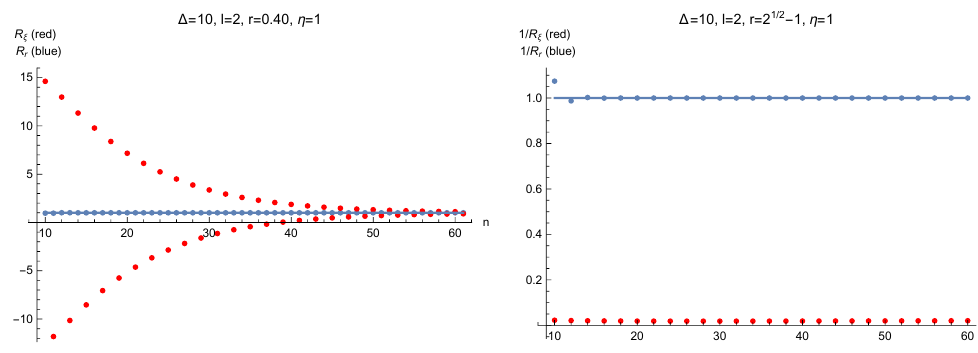
Figure 9 . Comparison of the expansion of the block g (cid:1) l of dimension (cid:1) = 10 and spin l = 2 in powers of (cid:24) (in red) and r (in blue). The meaning of the labels is as in eq. (4.20). The blue solid line is constant and equal to 1. The oscillation of R r and R (cid:24) , especially visible in the latter, follows from the fact that the two series expansions of the block are alternating. On the right, r is at the self-dual point, eq. (4.19). We plot R (cid:0) 1 because diverges at large n for (cid:24) R (cid:24) r;(cid:24) j j (cid:21)